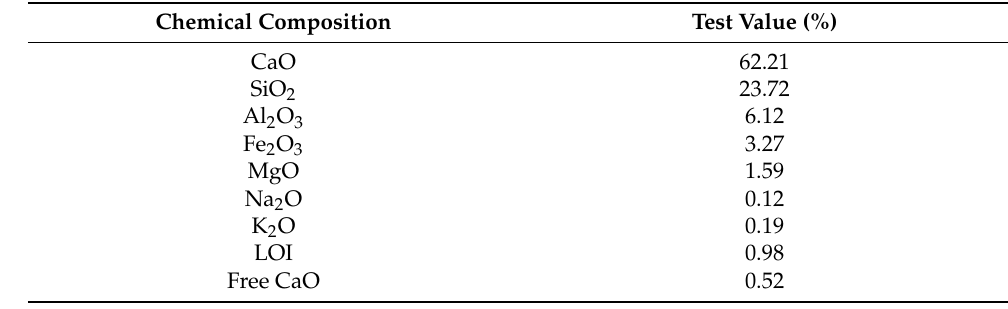
Table 2. Chemical properties of